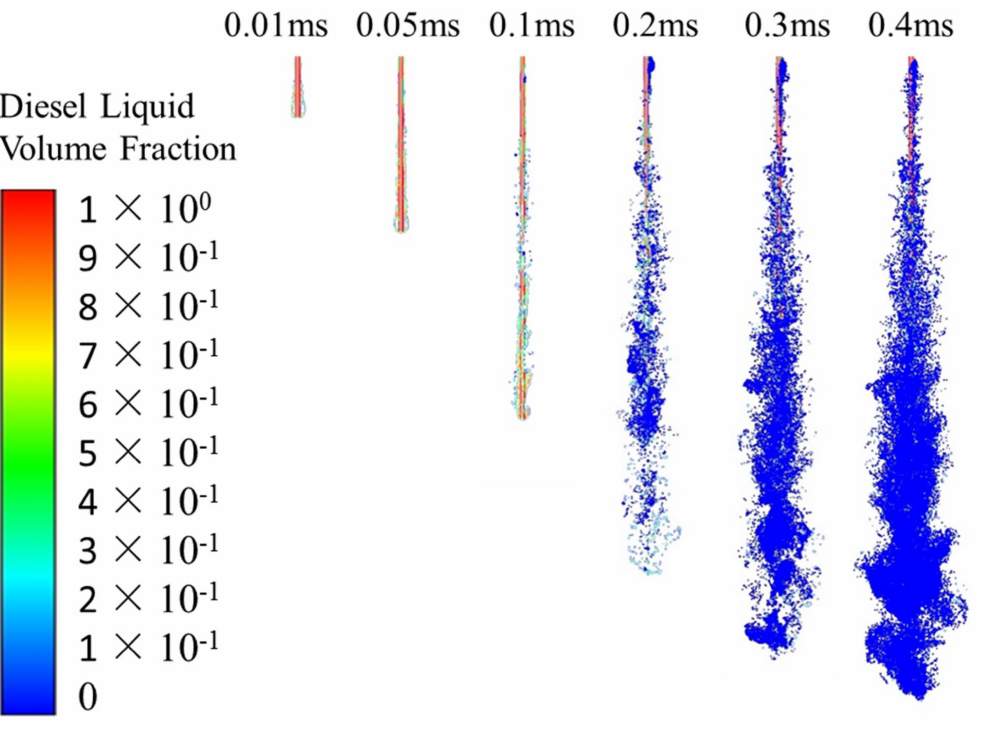
Figure 7. Diesel spray process of SD-ELSA model. ( p injection = 100 MPa, p b = 1